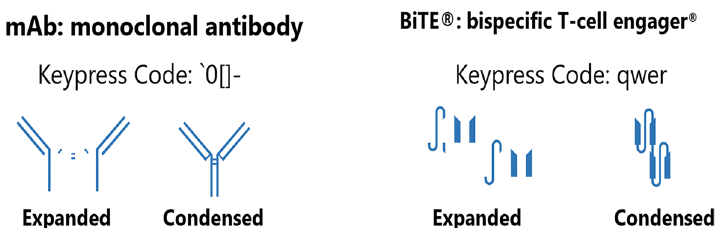
Fig. 2 Example Keypress codes for monoclonal antibody and BiTE ® bispecific T-cell engager molecules and the resulting expanded and condensed glyphs created using BioFonts